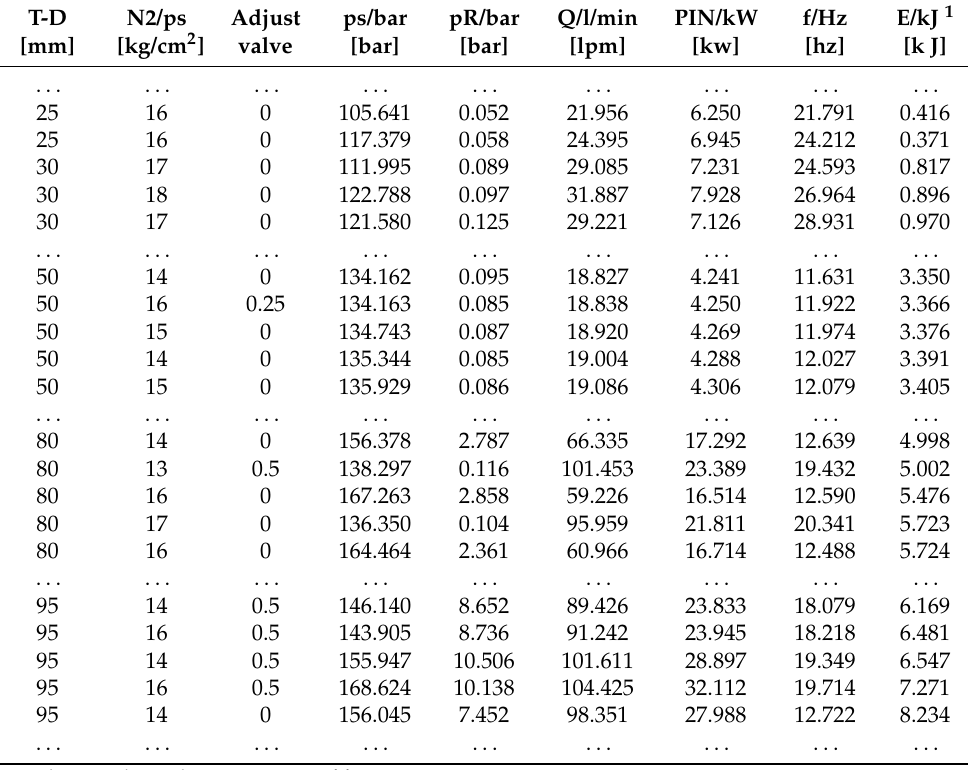
Table 2. Performance test data of small- and medium-class hydraulic breakers.